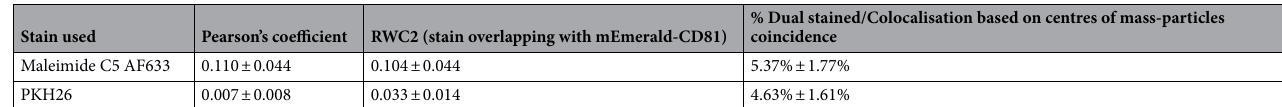
Table 2. A table summarising the quantitative colocalisation data of dual labelled mEmerald-CD81 EVs. Data was acquired from image analysis using the JACOPx ImageJ plugin. N = 3 (biological, 5 technical repeats per biological repeat) ±